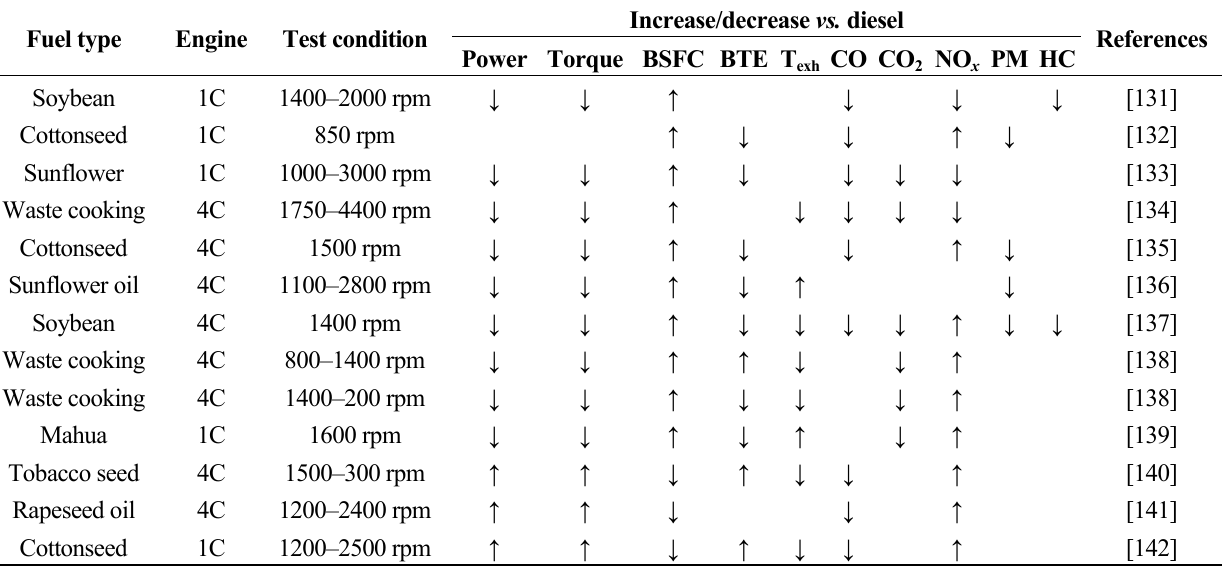
Table 6. Performance and emission of diesel engines with